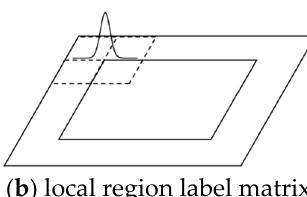
Figure 4. The comparison of label matrix between traditional circular samples and local region circular samples in time domain. The curves above the two label matrices denote the two-dimensional Gaussian distribution of both cases.